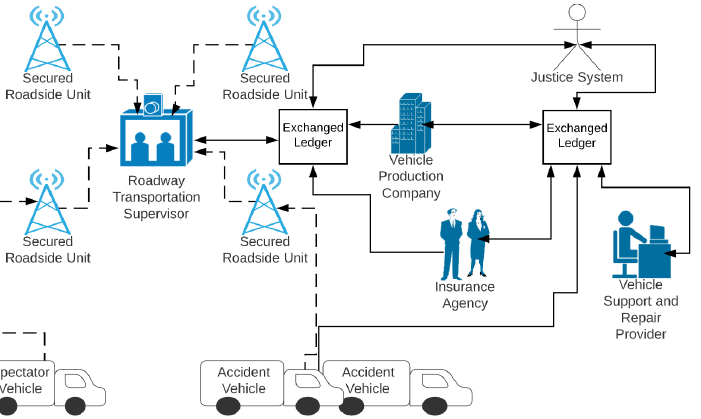
Figure 17. Different types of users who may have permission to operate on or with accident-related data under a tiered model, inspired by